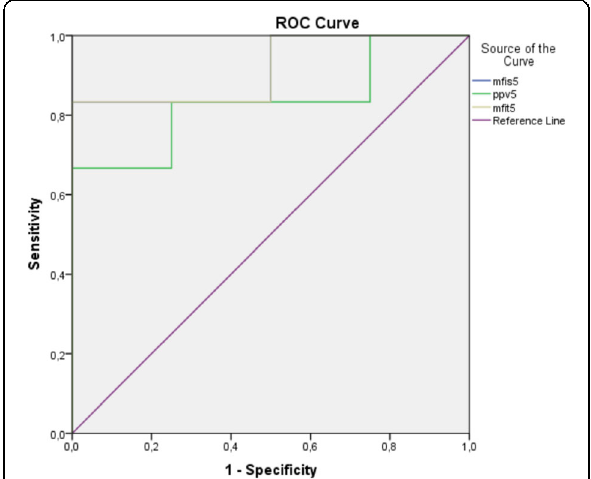
Fig. 2 (abstract 001592). Correlation between MR-proADM in patient with level > 1.5nmol/I and MFIs, PPV and MFIt at T5. AUC MFIs, 0.9 [CI 0,7-1] p=0.03, AUC PPV, 0.8 [CI 0.57-1] p=0.09, AUC MFlt 0.9 [CI 0.73-1] p=0.03. MR-proADM: midregional proadrenomedullin, MFIs5: Microvascular Flow Index for small vessels at T5, PPV: percentage of total perfused vessels at T5, MFIt5: Microvascular Flow Index for total vessels at T5, ICU: intensive care unit, CI: confidence interval, AUC: are under the